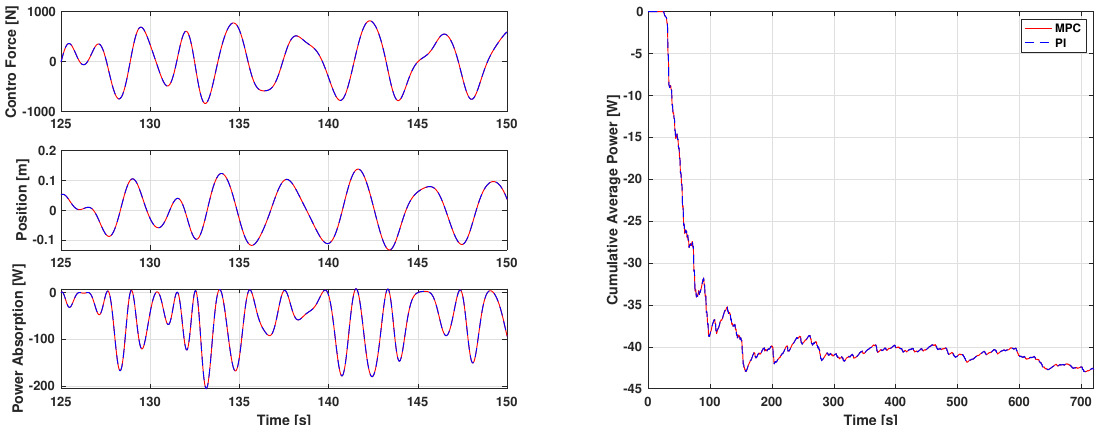
Figure 3. Comparison of the control forces, positions, power absorptions, and cumulative average power obtained by the proportional-integral (PI) controller and the model predictive control (MPC) (scenario